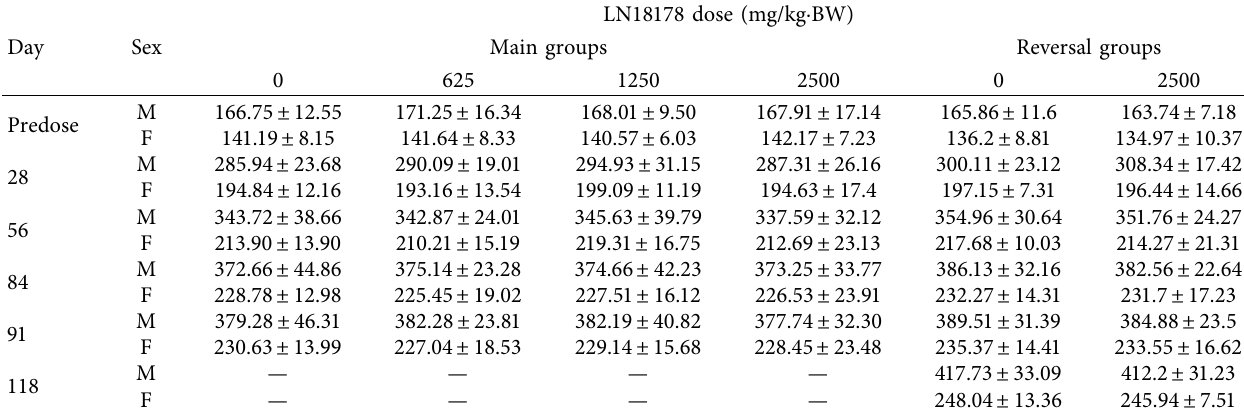
Table 1: Effect of 90-day oral administration of LN18178 on the body weights of male and female Wistar rats.